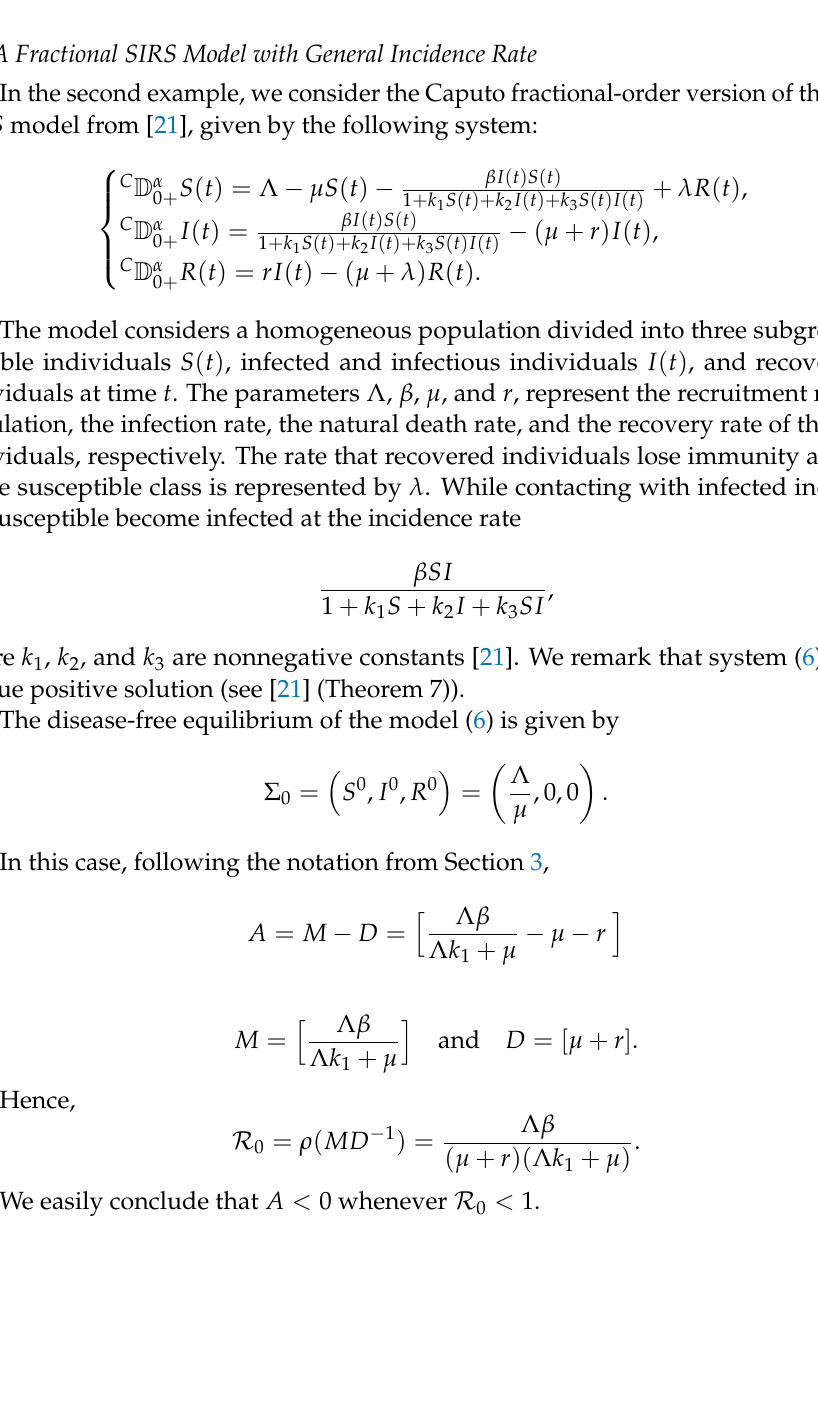
Figure 2. Global stability of the disease free equilibrium Σ 0 = ( 1,0,0, 0 ) , for the fractional model (3), considering α = 0.9 and different initial conditions x i , i = 0, . . . ,7, from (5). On the left S and on the right E + I + R